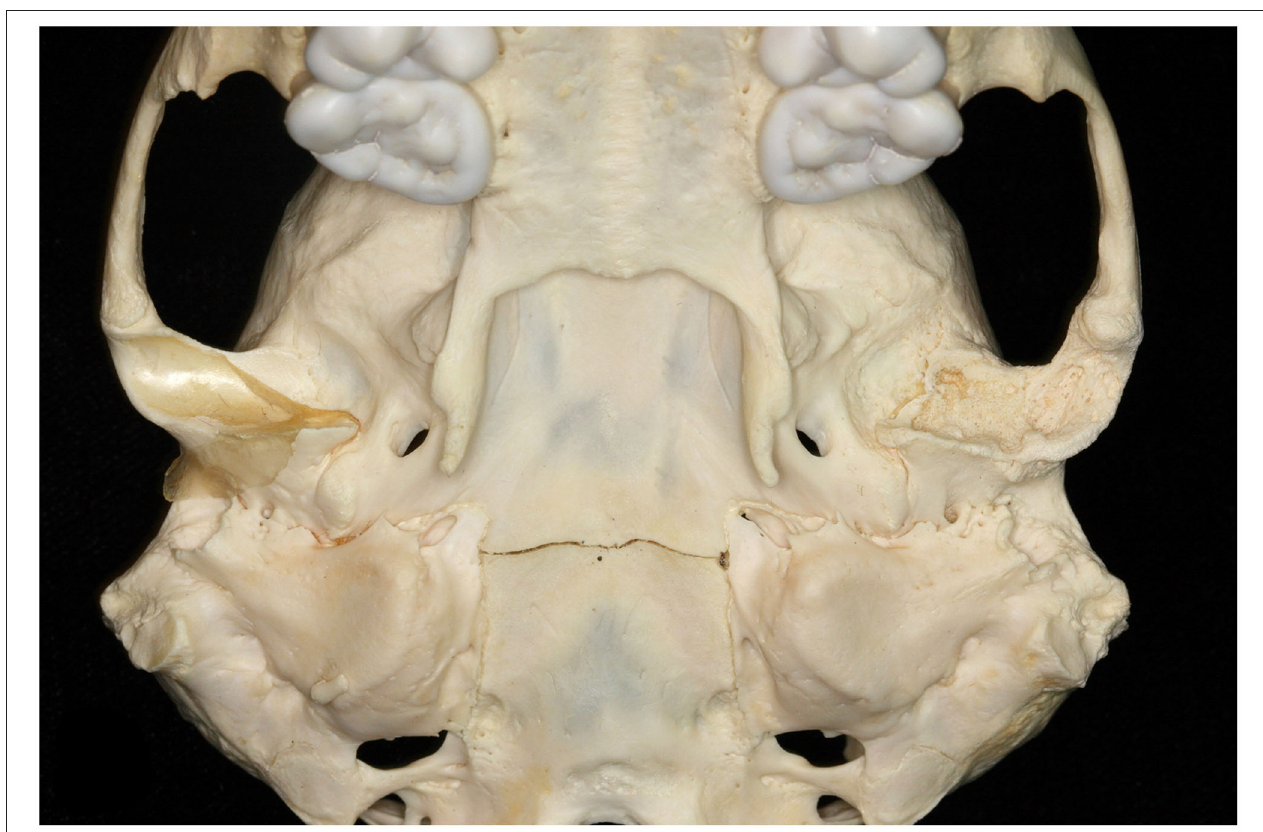
FIGURE 3 | Ventral view of unilateral TMJ-OA at the left mandibular fossa of a female southern sea otter ( Enhydra lutris nereis ). Note the absence of articular surface and severe destruction of the subchondral bone.